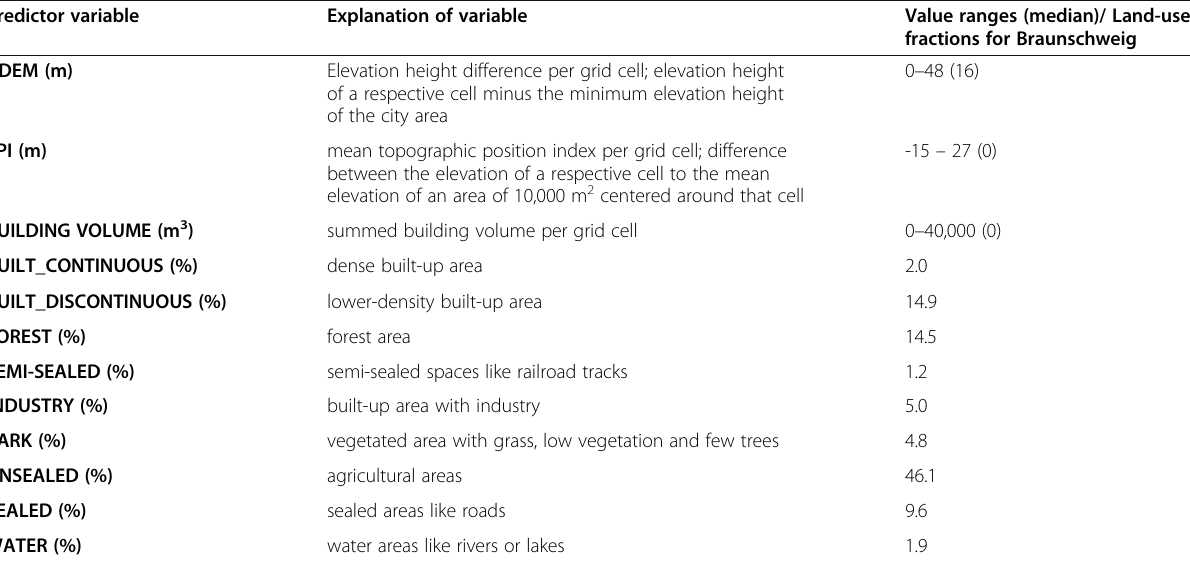
Table 1 Value ranges (median in brackets) of predictor variables Δ DEM (elevation height difference), TPI (topographic position index) and BUILDING VOLUME for Braunschweig. For the nine land-use classes fractions of the total urban area are given. The land- use classes are based on default land-use classes of KLAM_21 (cf. Grunwald et al.,